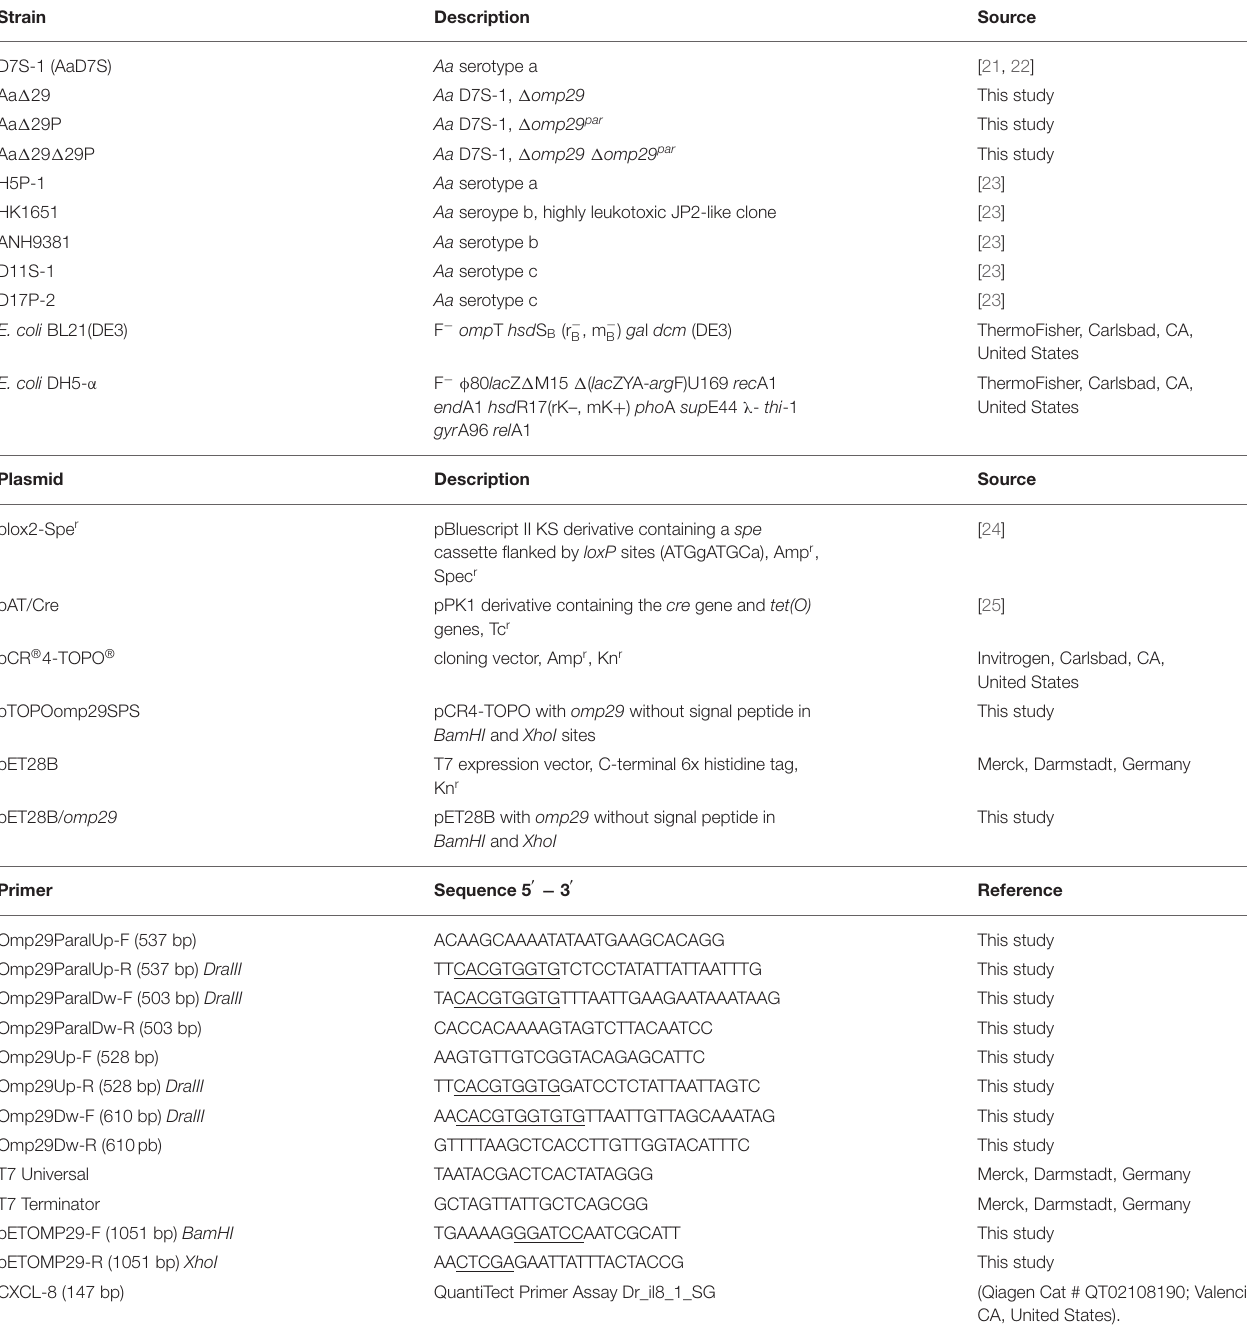
TABLE 1 | Strains, plasmids, and primers used in this study.